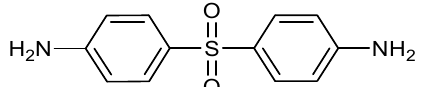
Figure 4. Chemical structure of 4, 4 ′ -diaminodiphenyl sulfone (DDS).